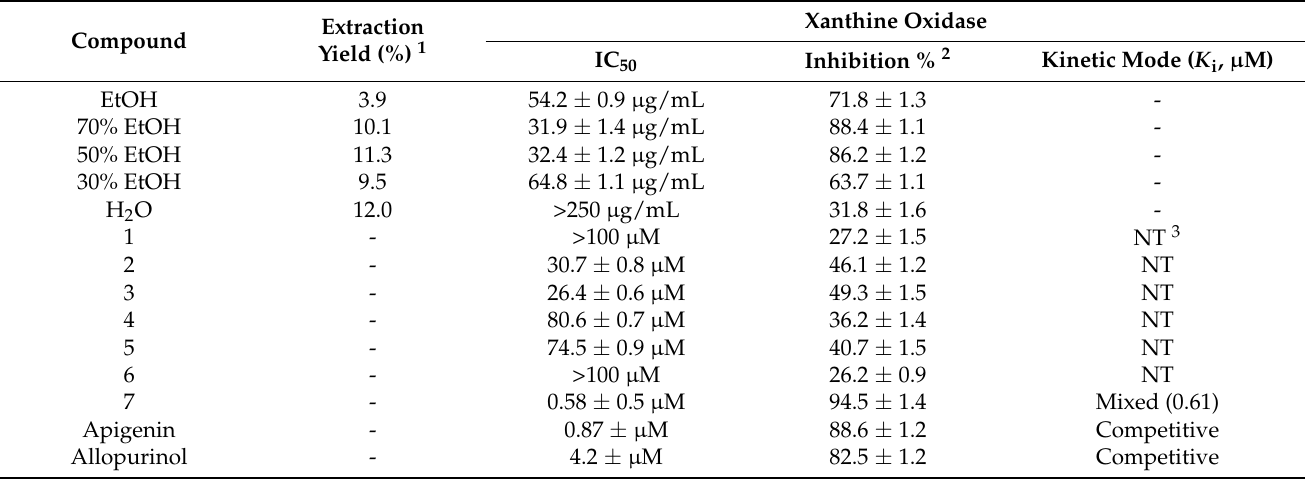
Table 1. XO Inhibitory effects of different solvent extracts and isolated compounds 1 – 7 in aerial parts of A. rugosa